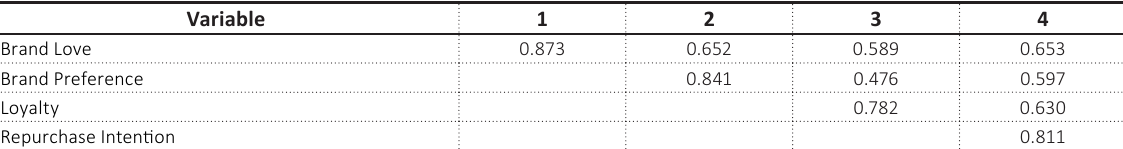
Table 2. Discriminant validity